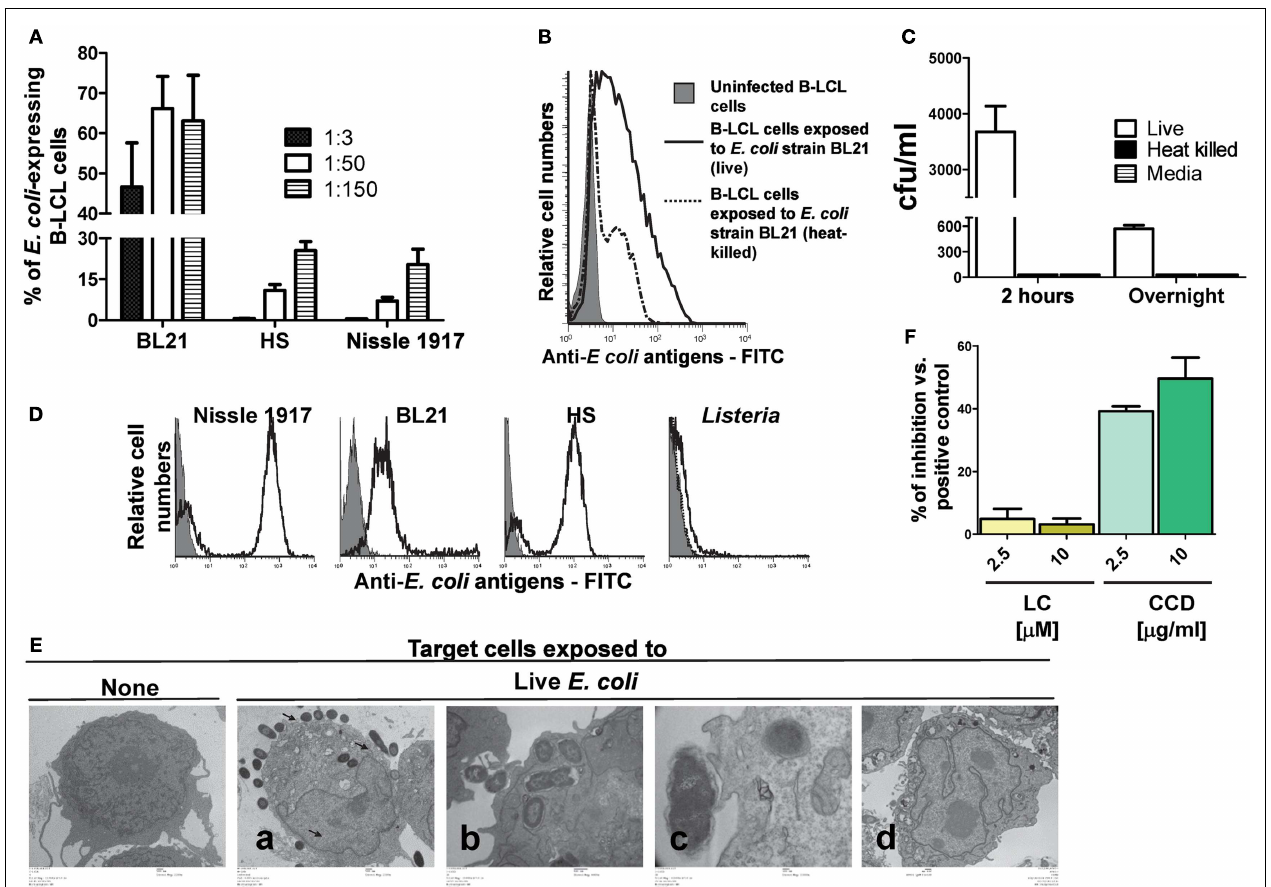
extracellular bacteria.The CFU was normalized per milliliter. (D) To confirm that anti- E. coli antibodies detect all E. coli strains being studied, these E. coli strains as well as Listeria (negative control) were directly stained with E. coli antibodies and analyzed by flow cytometry. (E) Infection was further confirmed by electron microscopy. B-LCL cells were left untreated (none, lower magnification) or exposed to live E. coli strain BL21 at a MOI of 1:100 [from left to right, lower (a) , medium (b) , or higher (c) magnification] and treated with gentamicin for 2h. After 2h, B-LCL cells were washed and cultured overnight in complete media with gentamicin (d) to control for bacteria detachment. (F) In some experiments B-LCLs were pretreated with lactacystin (LC) and cytochalasin D (CCD) for 2h at different concentrations before infection. Data are representative of five (A) , three (B) , and two (C–F)